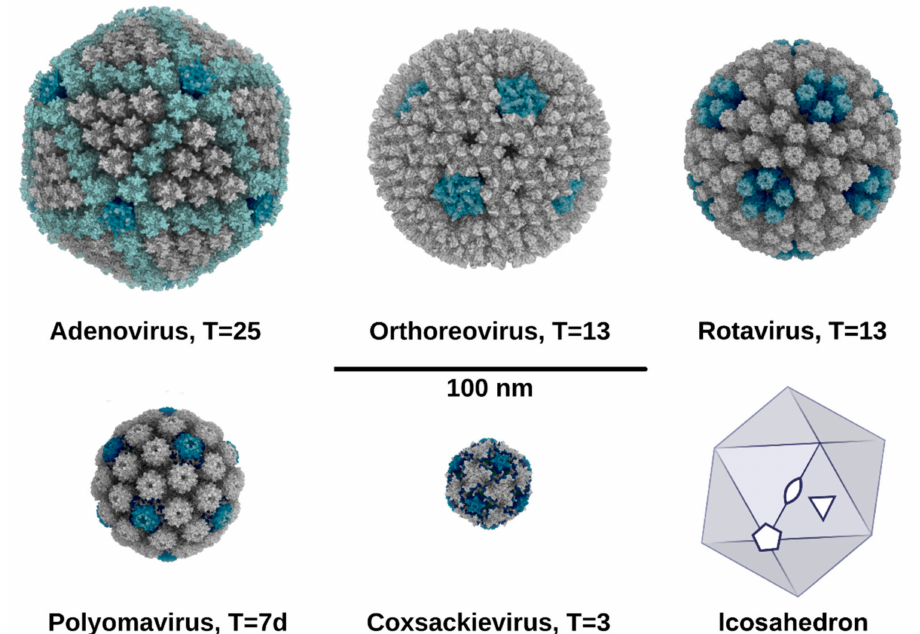
Figure 3. Representation of the architecture and symmetry of a selection of non-enveloped, sialic acid binding viruses. Particle illustrations are sorted by descending virion diameter, disregarding any protruding domains or fibers. The views are positioned along the icosahedral two-fold axes. Five-fold vertices and the associated capsid proteins are highlighted in blue. A schematic view of an icosahedron in the same orientation is shown on the lower right, with two-fold, three-fold and five-fold axes indicated as ellipse, triangle and pentagon, respectively. PDB IDs 6b1t (adenovirus), 2cse (orthoreovirus), 3kz4 (rotavirus), 1sid (polyomavirus), and 4q4w